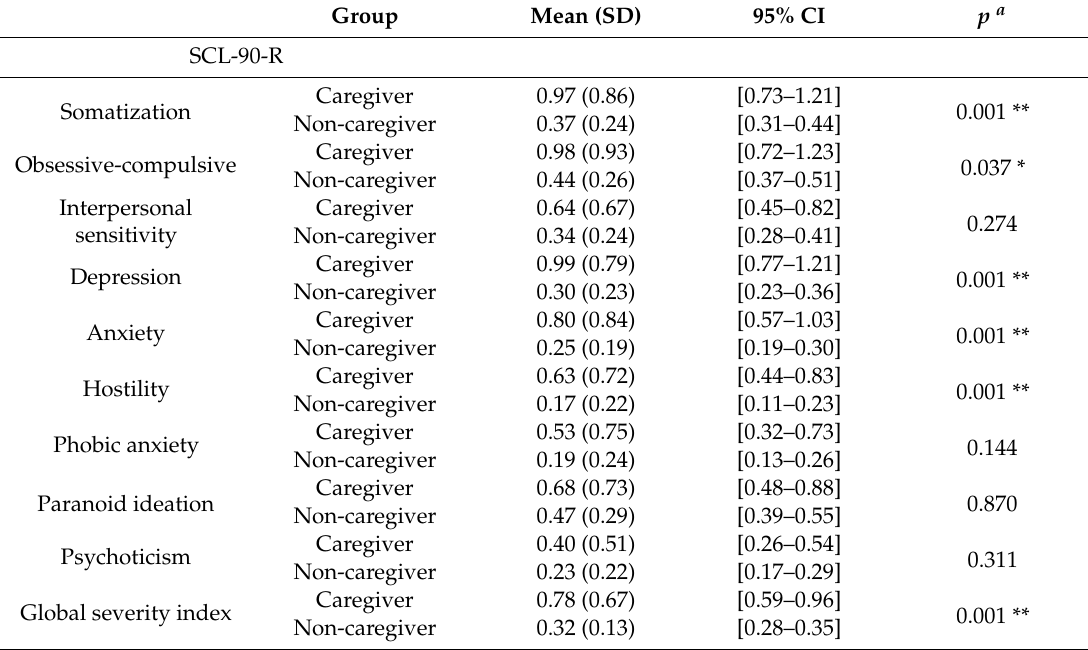
Table 2. Comparison of psychological symptoms and global severity index (from the Symptom Check-List-90-Revised (SCL-90-R)) between